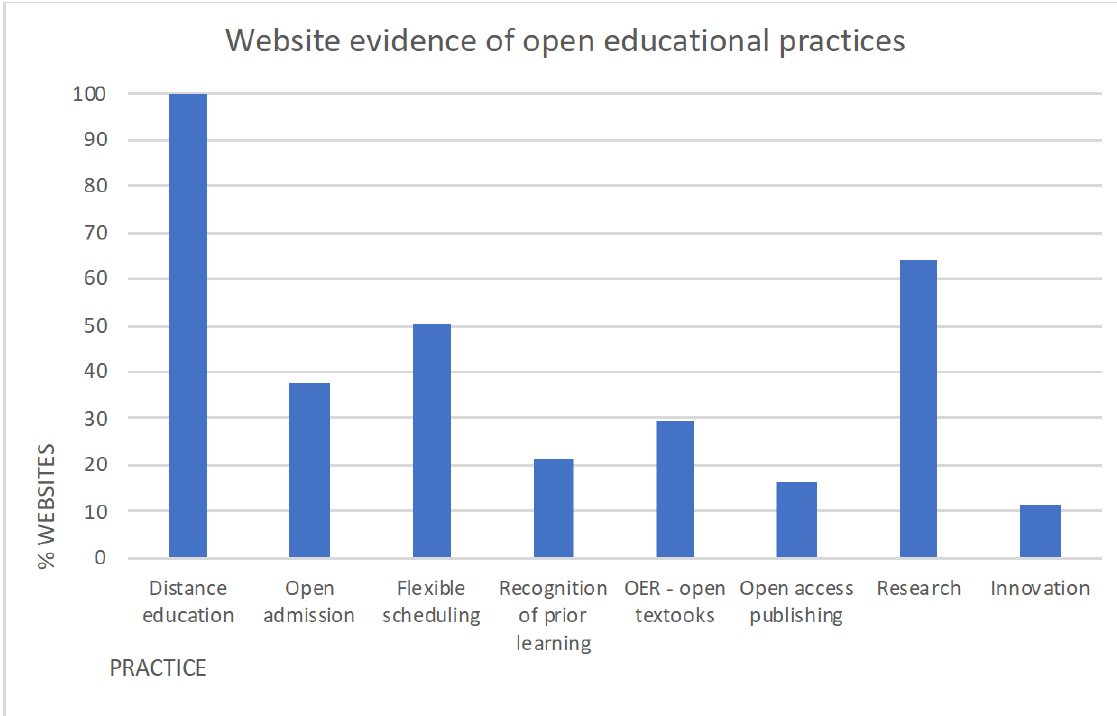
Figure 3. Website evidence of open educational